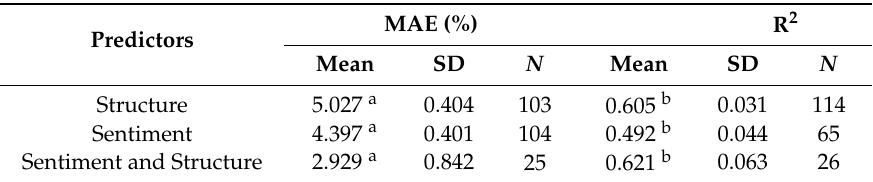
Table 2. Covariate-adjusted means of sentiment, structure, and combination approaches.